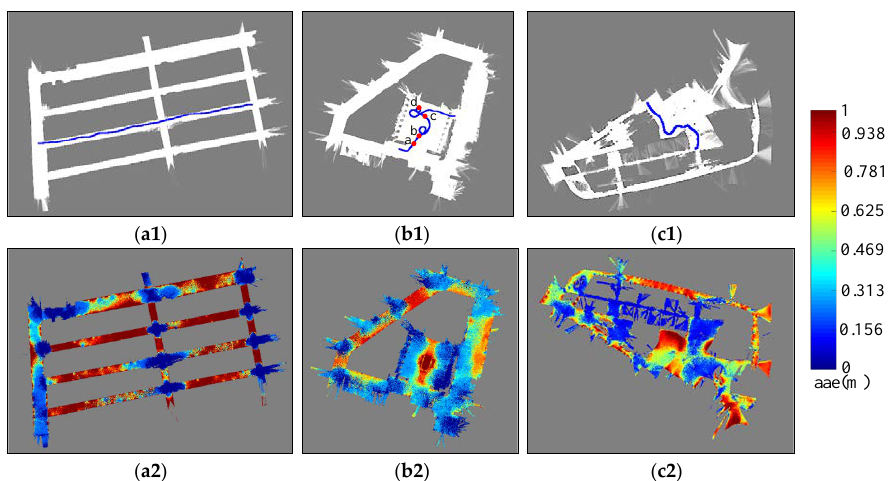
Figure 11. AGMs of real-world environments: ( a1 – c1 ) are the occupancy grid maps of scene A, B and C. ( a2 – c2 ) are the corresponding AGMs. Blue curves show the ground truth for localization simulation. Those positions in the middle of a long corridor, in the center of an open square, near a straight-line wall and tangled thicket get high AAE value.